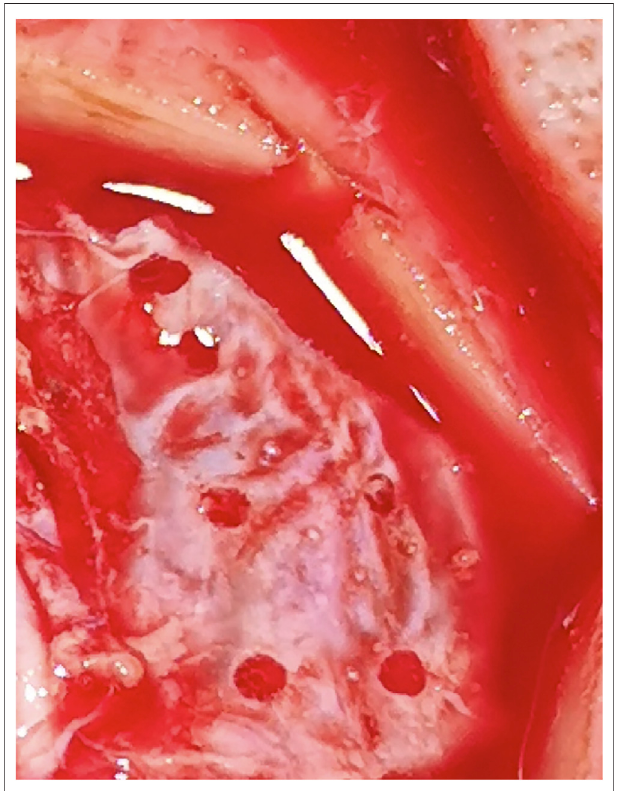
FIGURE 6 | The dura was punctured with one, two, and three laser beams, respectively.